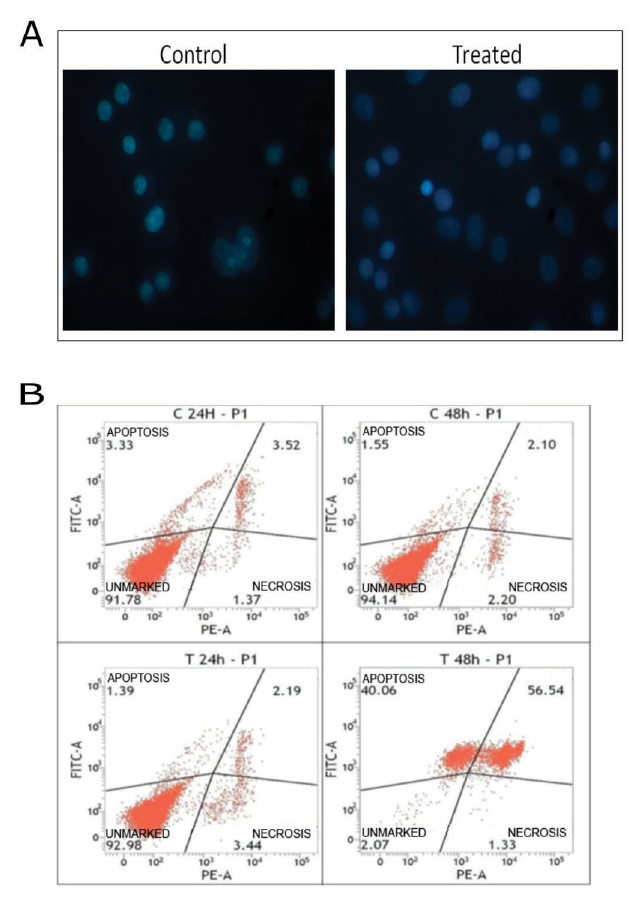
FIGURE 5 - (A) Analysis of nuclear morphology in fluorescence microscope using Hoechst® 33258 dye (at 1 μg/mL) in SiHa cells treated with the E. uniflora aqueous crude extract (at 7.8 mg/mL) for 24 hours. (B) Flow cytometry analysis of the cell death mechanism by the labeling with annexin V / propidium iodide in SiHa cells treated with the E. uniflora aqueous crude extract (at 7.8 mg/mL) for 24 and 48